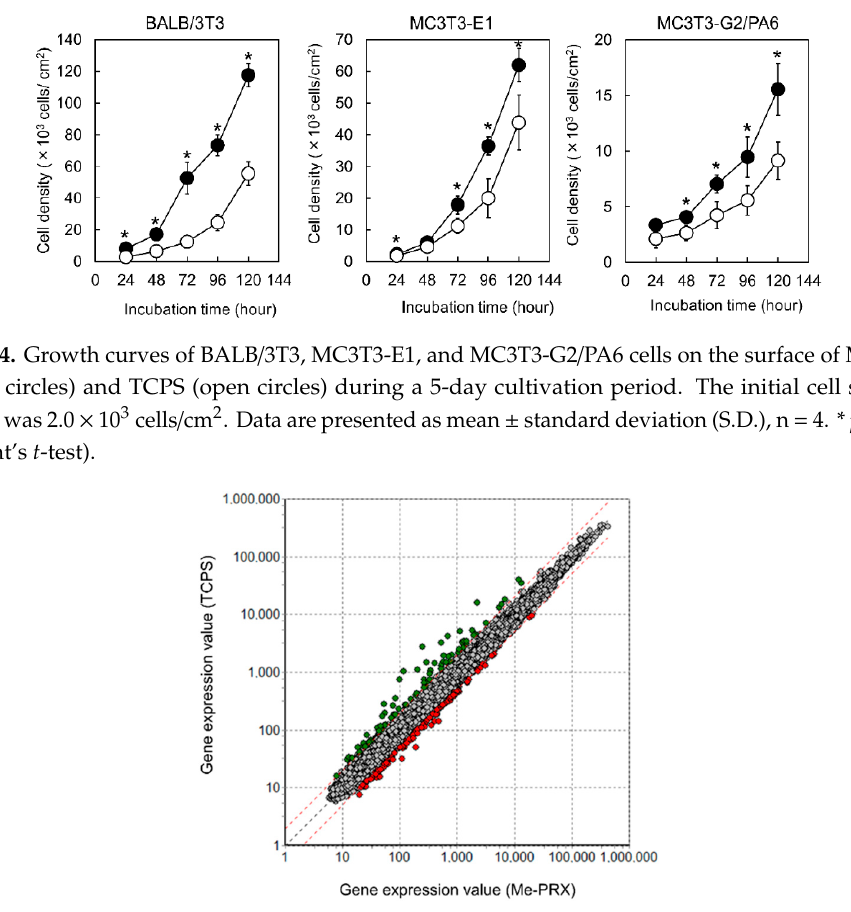
Figure 5. Scatter plot representation of global gene expression profiles in BALB/3T3 cells on Me-PRX (twofold change threshold). Global gene expression profiles of cells on Me-PRX surfaces were compared with those of cells on TCPS surfaces. Red circles: upregulated genes; green circles: downregulated